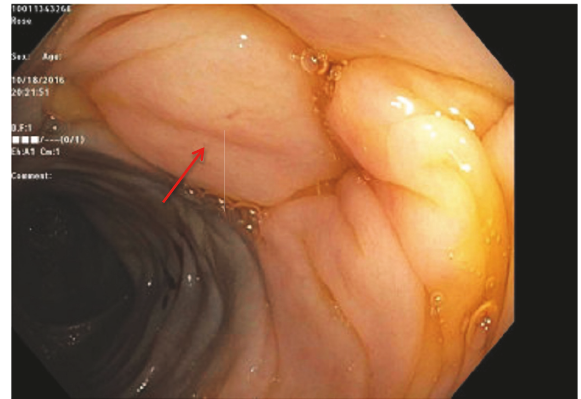
Figure 3: Pneumatosis coli of the transverse colon (arrow).